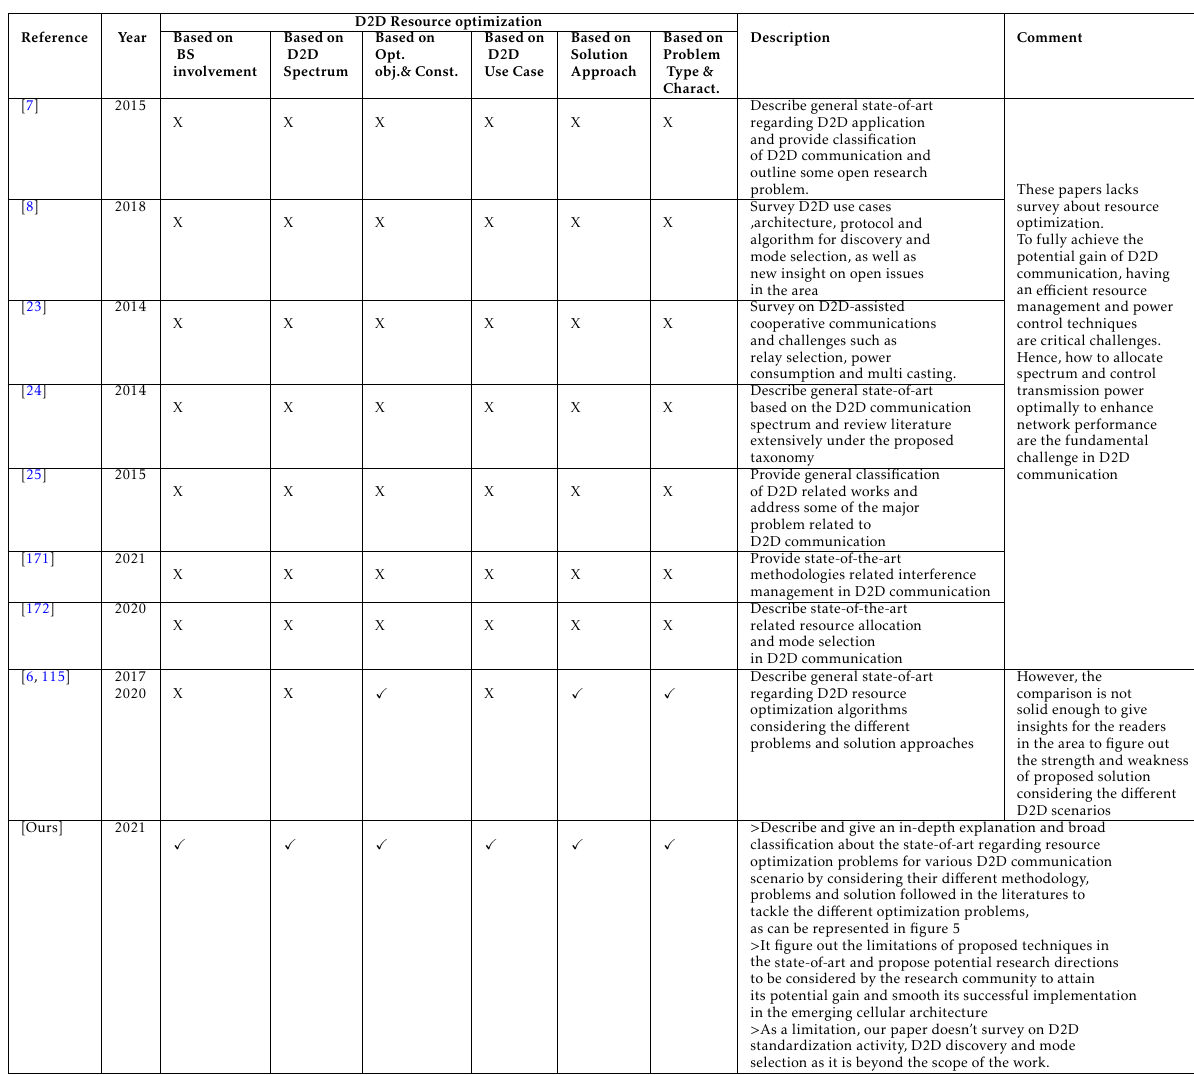
Table 2. Comparison of our survey with existing